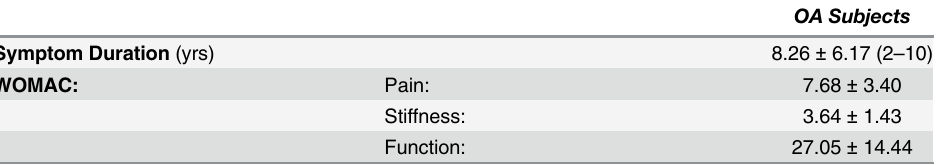
Table 2. Mean ( ± SD) duration of self-reported symptoms and Western Ontario and McMaster (WOMAC) scores for knee OA